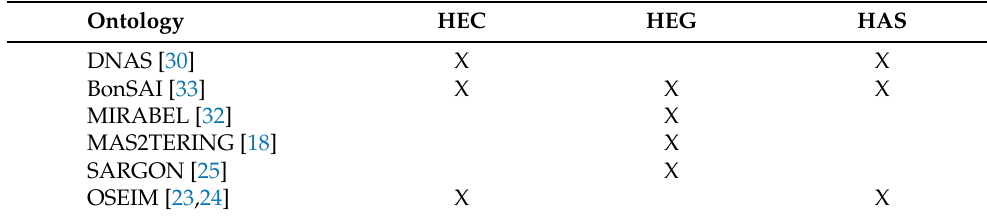
Table 2. Complementary ontologies.